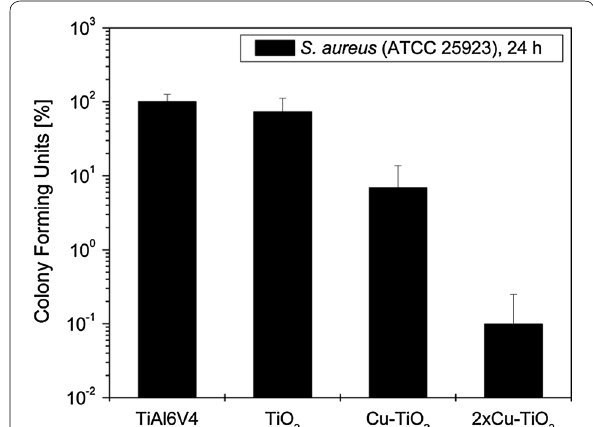
Fig. 7 Growth of S. aureus ATCC 25923 in the supernatant growth medium for cultivation of uncoated and the different TiO 2 -coated TiAl6V4 samples after 24